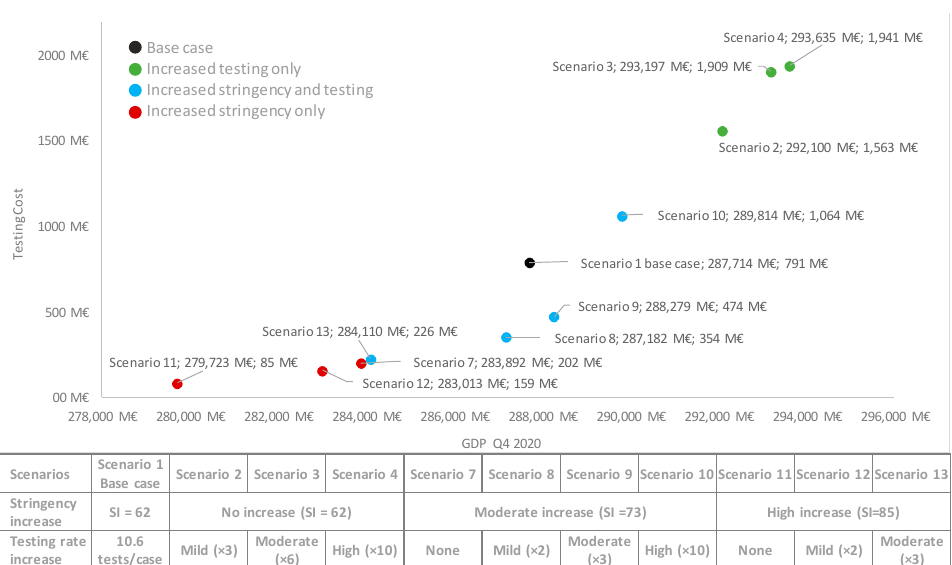
Figure 6 . Potential Q4 GDP 2020 evolution for different scenarios of testing and stringency . GDP in million €; % change vs. GDP from Q4 2019. M€: million €.